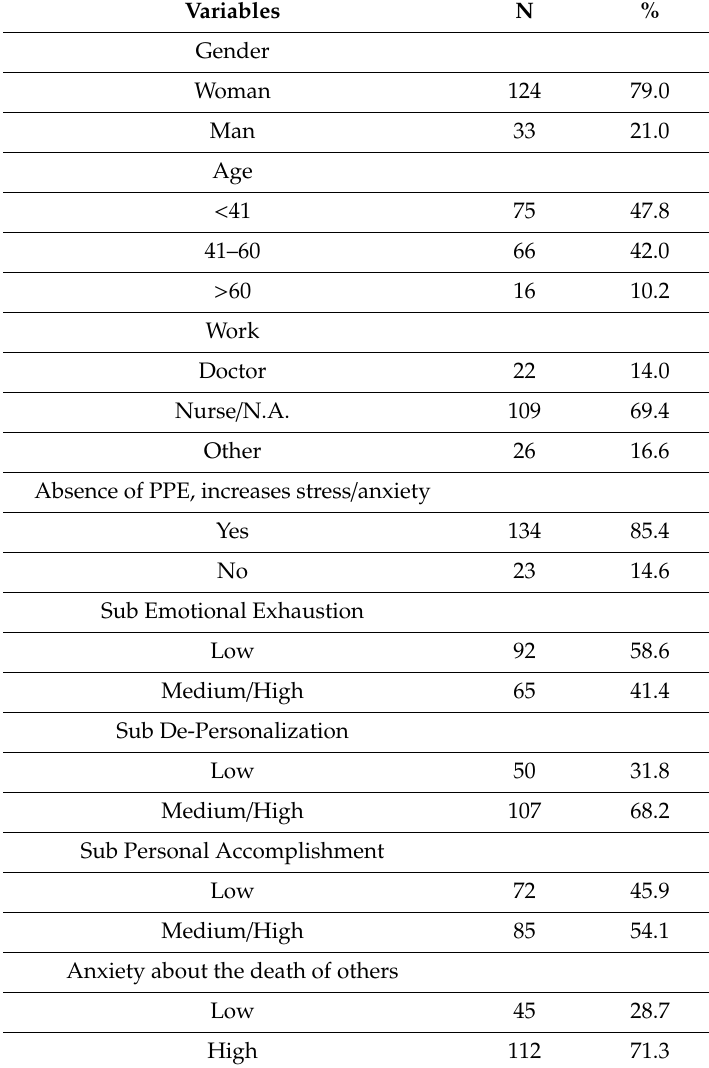
Table 1. Descriptive analysis of the